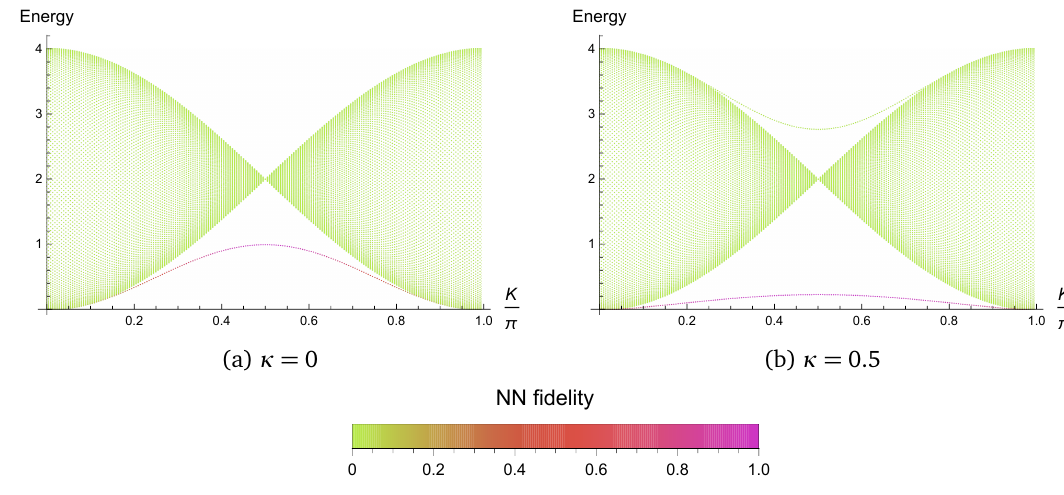
Figure 1: Two-magnon excitations and nearest neighbor fidelity of the ferromagnetic quantum Ising-Kawasaki spin chain with N = 200 for (a) κ = 0 and (b) κ = 0.5. For κ = 0 we recover the Heisenberg XXX known result [ 39 ]